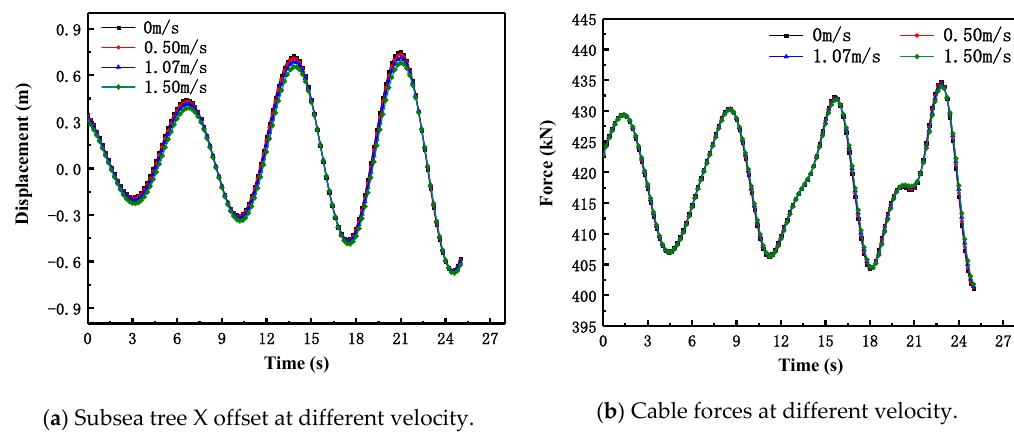
( b ) Cable forces at different velocity. Figure 7. Subsea tree o ff set and cable forces at di ff erent Figure 7. Subsea tree offset and cable forces at different velocity. Figure 7. Subsea tree offset and cable forces at different velocity.